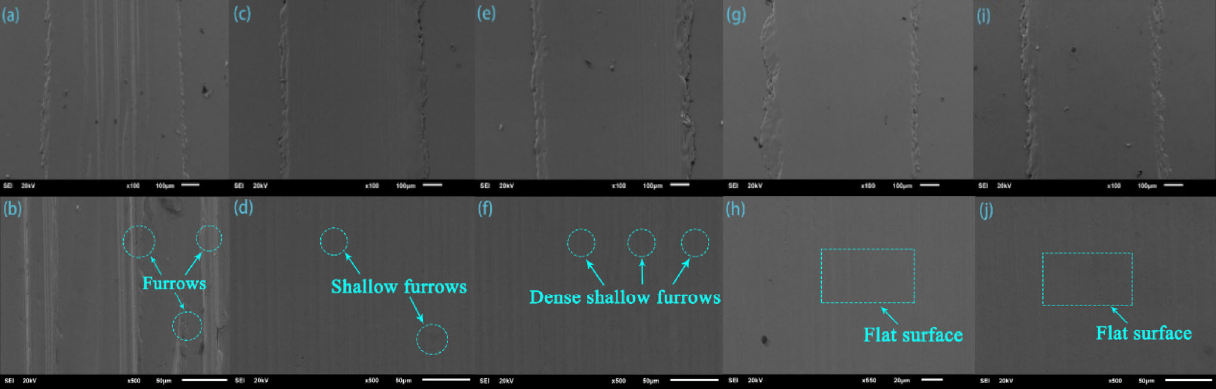
Fig. 9 SEM images of copper plate surfaces lubricated with different greases: (a, b) LCG, (c, d) 2% IL-PANI, (e, f) 3% WS 2 , (g, h) 2% PW10, and (i, j) 2% PW30 (voltage: 1.5 V; load: 15 N; frequency: 2 Hz; stroke: 5